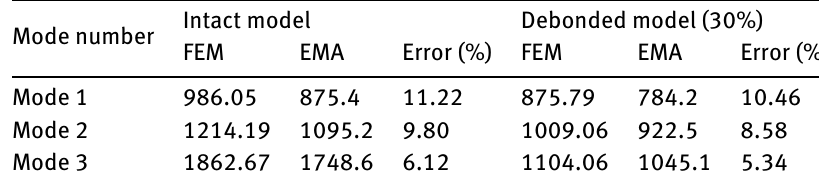
Table 3: The natural frequency between experimental test (EMA) and numerical analysis (FEM).